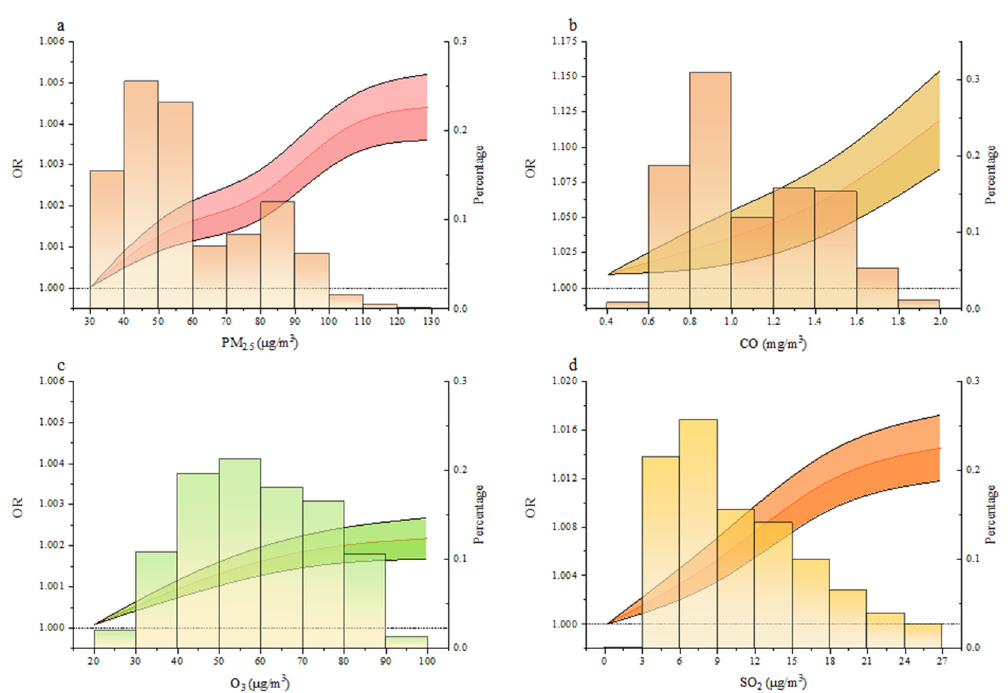
Figure 3. Exposure–response curve between air pollutant exposure and the risk of gynecological cancer. ( a – d ), Exposure– response curve of gynecological cancer risk with respect to PM 2.5 ( a ), CO ( b ), O 3 ( c ), and SO 2 ( d ) exposure. The red line represents the OR value, and the black line denotes the 95% confidence intervals. The histogram shows the distribution of the corresponding pollutant concentration. Here we controlled confounders.